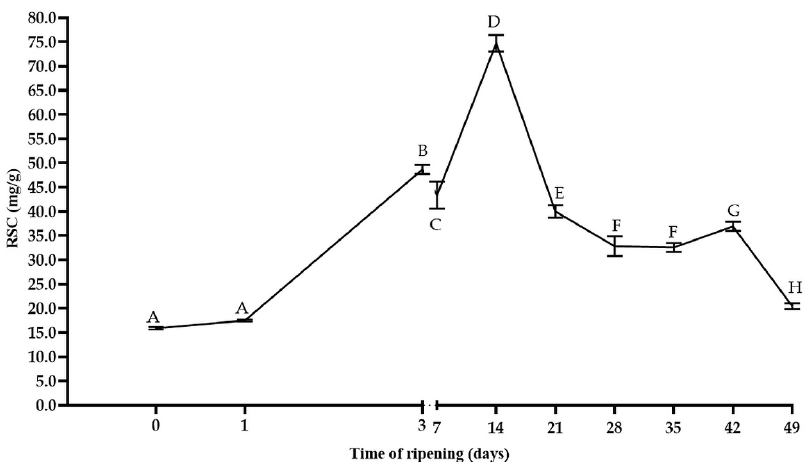
Figure 4. Changes in the Reducing Sugars Content during the ripening. Means with different let- ters (A–H) are significantly different at p <